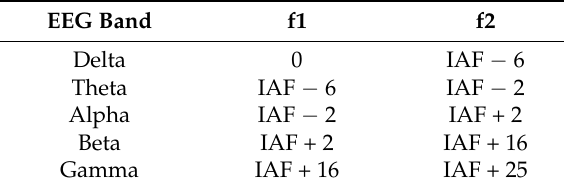
Table 1. EEG bands definition by means of the individual alpha frequency (IAF)